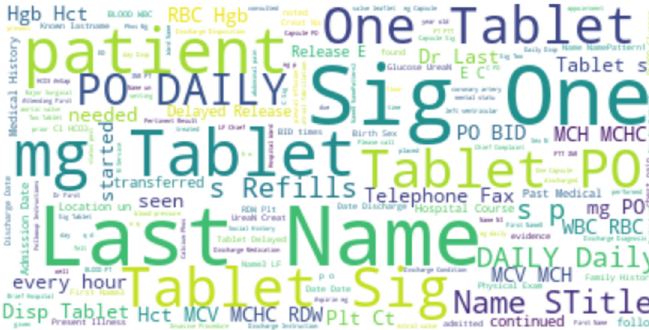
Figure 3. Word cloud for the discharge summary notes for all patients.